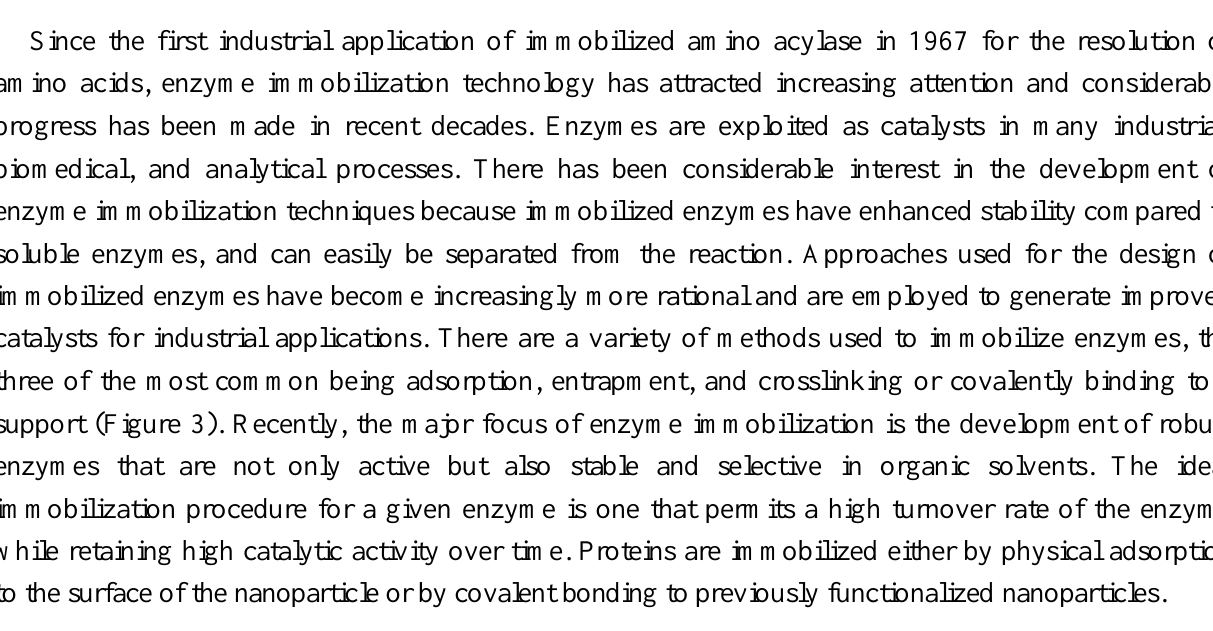
Figure 3. Immobilization of enzyme via different